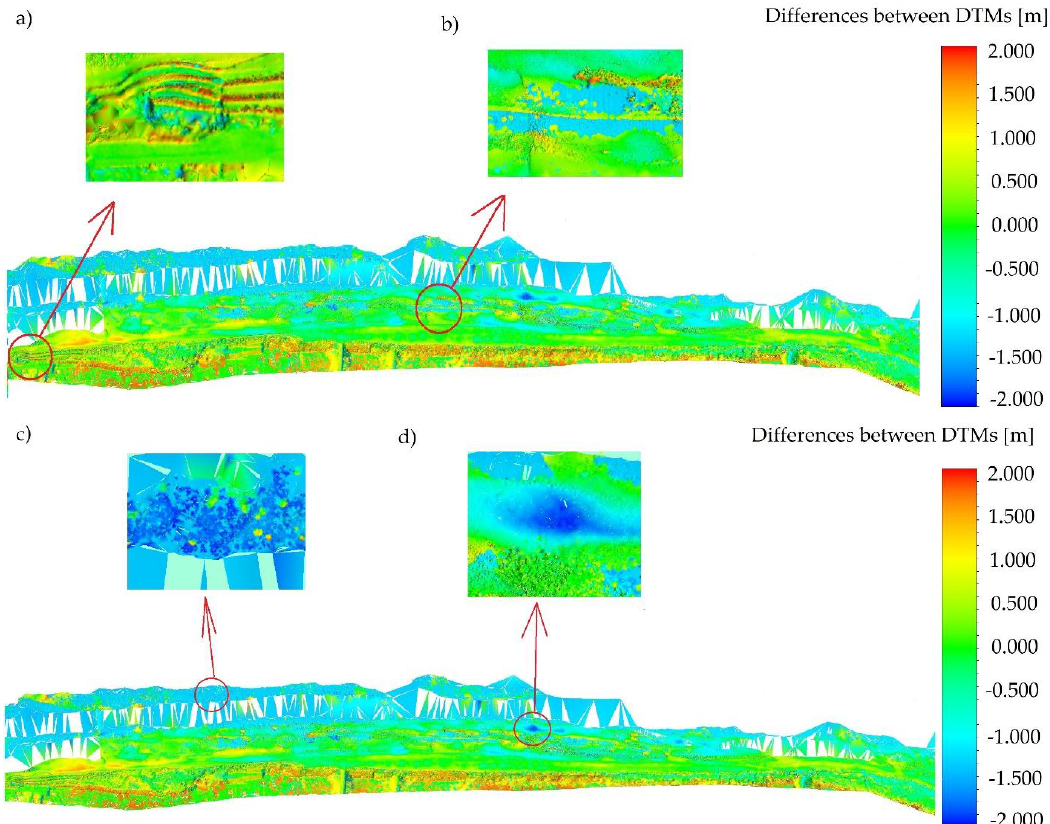
Figure 11. Identification of sites characterized by the largest positive change between Digital Terrain Models from ALB data from Autumn and Winter seasonal change ( a ), ( b ) and the largest negative change between DTMs from Autumn and Winter seasonal change ( c ), ( d ).